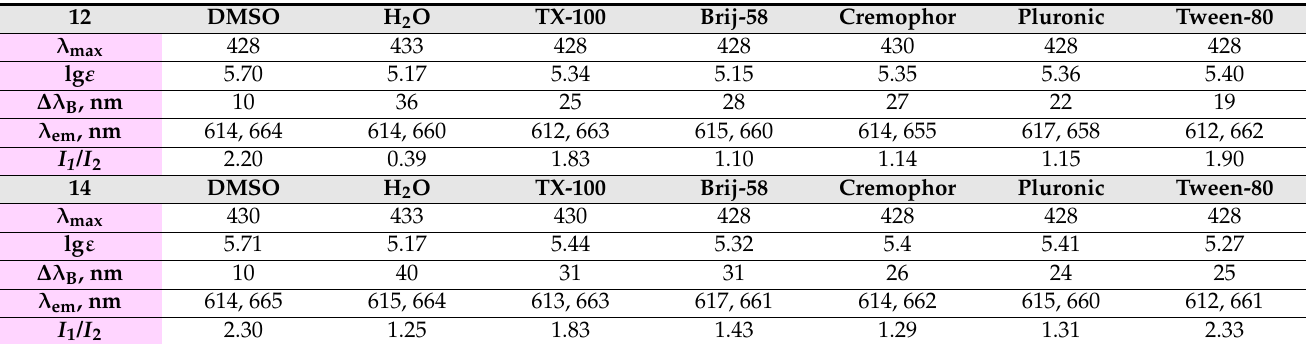
Table 3. Spectral parameters of 12 and 14 in aqueous solutions of different solubilising